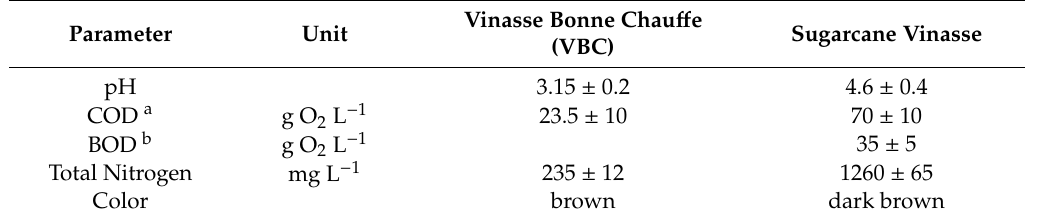
Table 1. Average characteristics of a vinasse “de bonne chau ff e” of cognac (data provided by Revico) and of raw sugarcane vinasse before the experiment. a Chemical Oxygen Demand, b Biological Oxygen